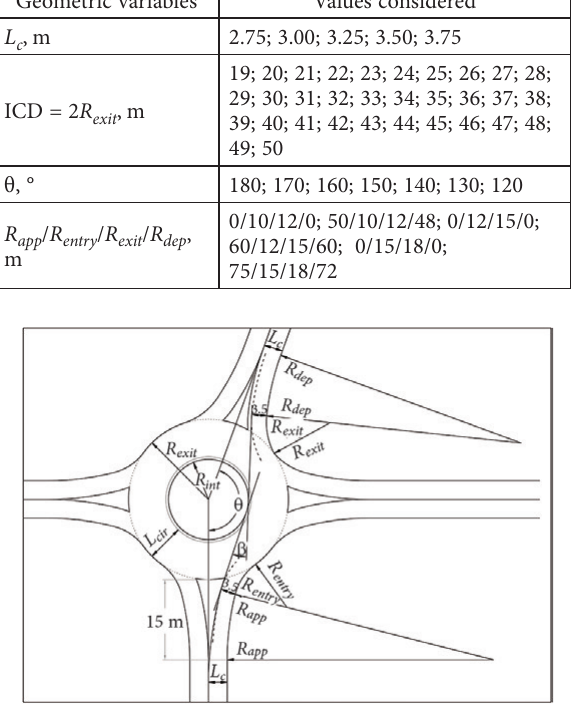
Figure 2. Geometric variables considered for the